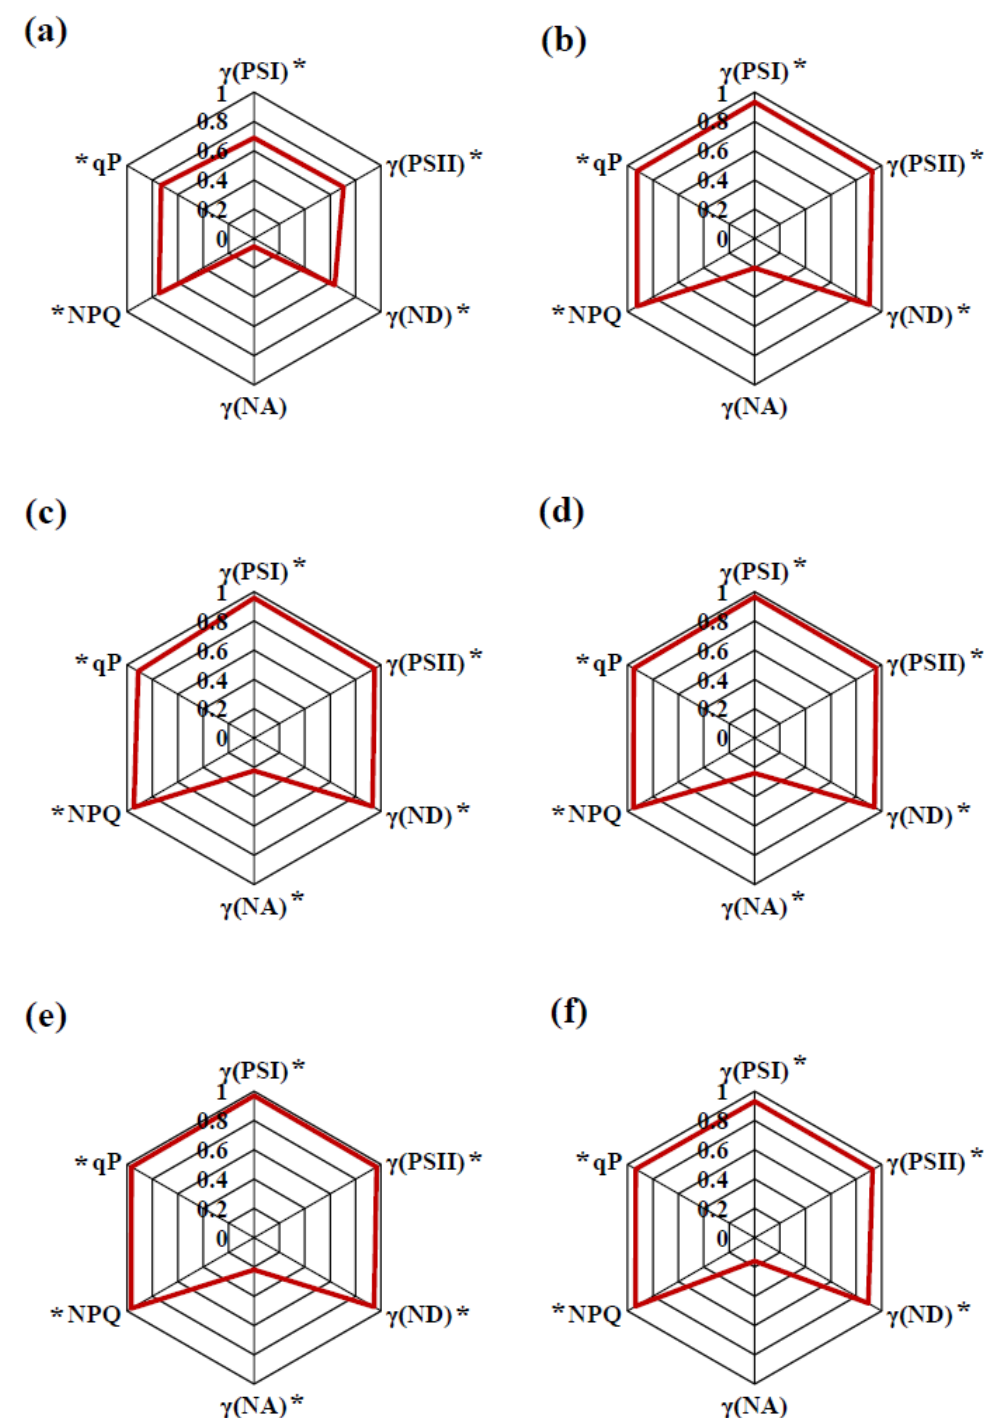
Figure 6. Determination coefficients (R 2 ) for the linear regressions, which were calculated on the basis of light averaged experimental values (only time points measured under actinic light) of the photosynthetic parameters and ∆ PRI(515,570) (a) , ∆ PRI(525,570) (b) , ∆ PRI(531,570) (c) , ∆ PRI(535,570) (d) , ∆ PRI(545,570) (e) , and ∆ PRI(555,570) (f) . The coefficients were calculated on the basis of the results from Figures 2 and 3; the details of the relations are shown in Figures S7–S12 (Supplementary Materials). * indicates that the relation was significant ( p < 0.05 for the correlation coefficients between these values).